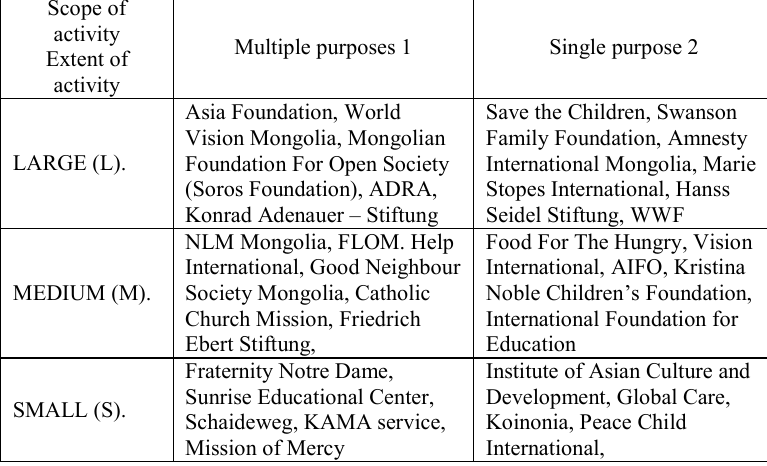
Table 2 . Categorization of International NGOs in Mongolia Scope